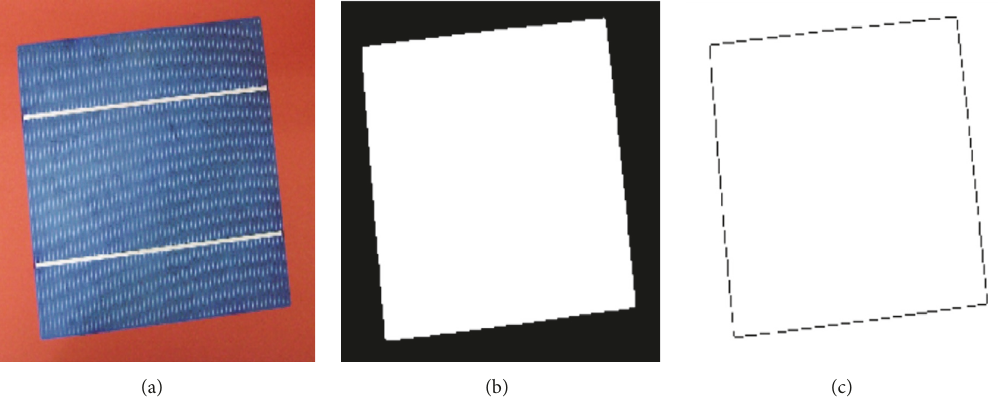
Figure 4: Red background solder panel image processing: (a) original image; (b) HPD thresholding; (c) initial edge extracted by fractional Gaussian template.